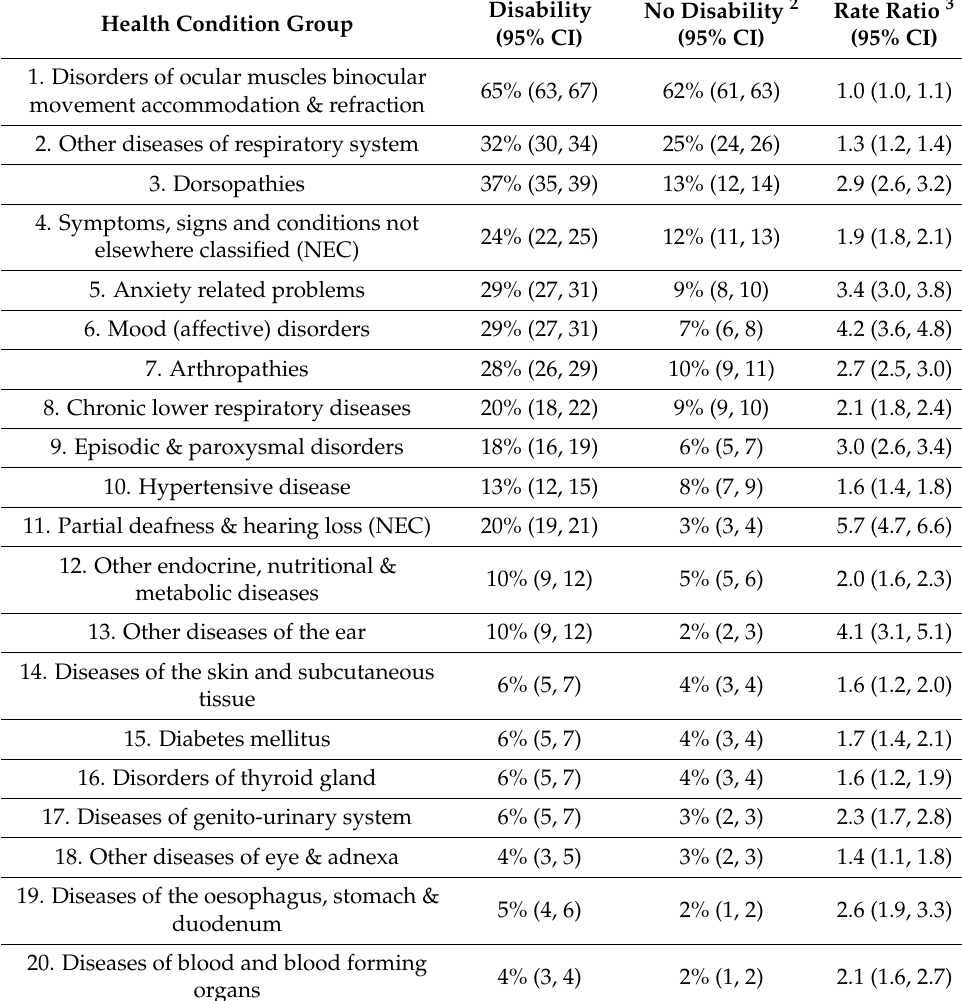
Table 1. Prevalence of the 20 most commonly reported 1 current, long-term health conditions, by disability status, for people aged 15–64 years (National Health Survey